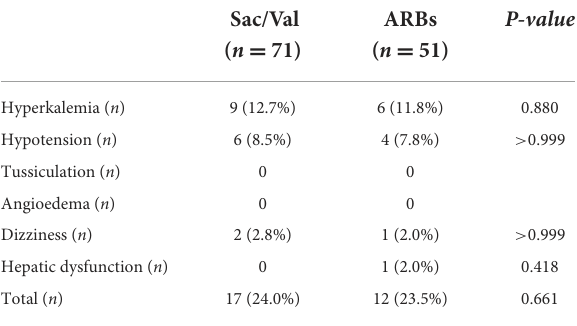
TABLE 5 Adverse events during 3 months of